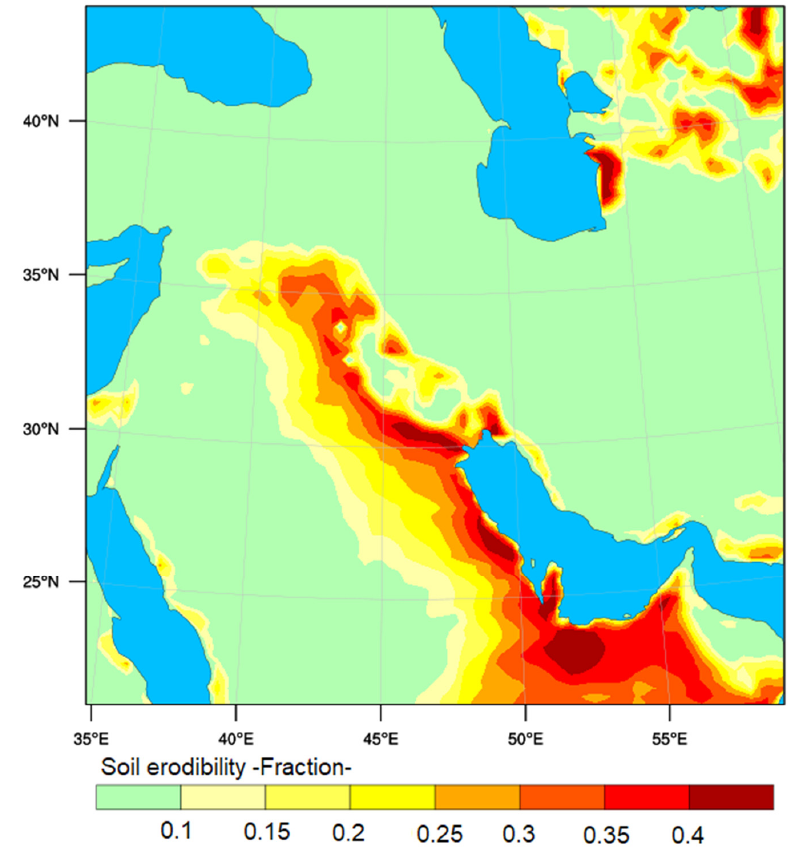
Figure 8. Soil erodibility map between 45°30 ′ 00 ″ E and 49°30 ′ 00 ″ E and between 30°00 ′ 00 ″ N and 35 ◦ 00 (cid:48) 00” 35°00 ′ 00 ″ N.